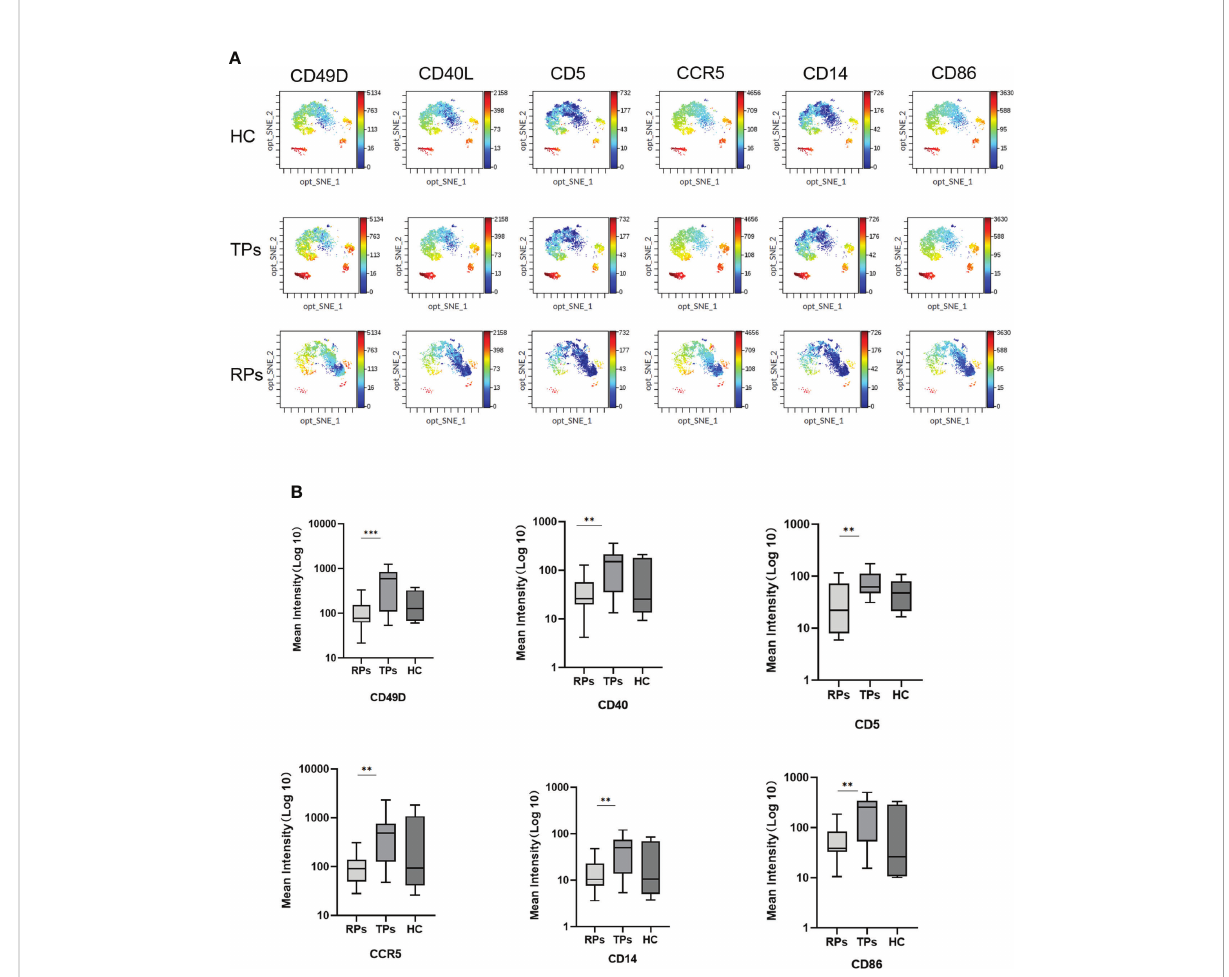
FIGURE 9 The mean intensity of six differential Exosomes membrane biomarkers. (A) The result of mass cytometry. (B) Quanti fi cation of the mean intensity. **p < 0.01, ***p <